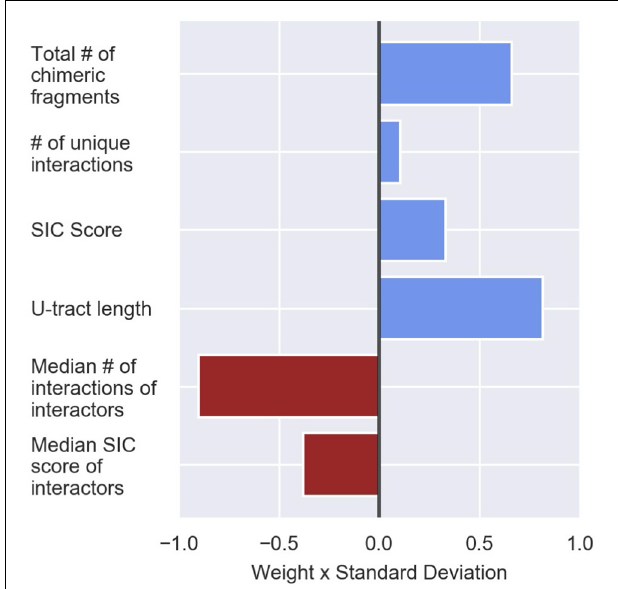
FIGURE 4 | Contribution of the various features to the logistic regression predictions. Presented are the logistic regression weights after z-score transformation of the feature values (see the section “Materials and Methods”). The presented weights, which are the original weights ( Table 3 ) multiplied by the standard deviation of the feature value, are comparable. The weight value represents its contribution to the probability the logistic regression model provides, and the sign signifies the direction in which the weight affects this probability (i.e., positive values increase the sRNA probability and negative values reduce the sRNA probability). The results are based on the data set of stationary phase RIL-seq experiment. Results for the exponential phase data sets are shown in Supplementary Figure 10